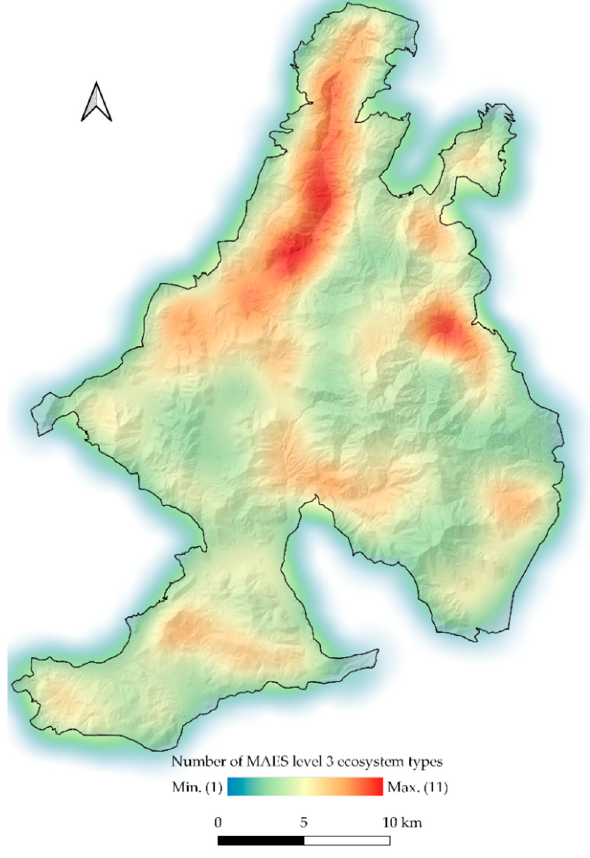
Figure 7. MAES level 3 ecosystem type diversity hotspots in the CVNP area. Table 6. Synoptic results for ecosystem condition assessment via field surveys using the MAES_GR online platform [42] at the